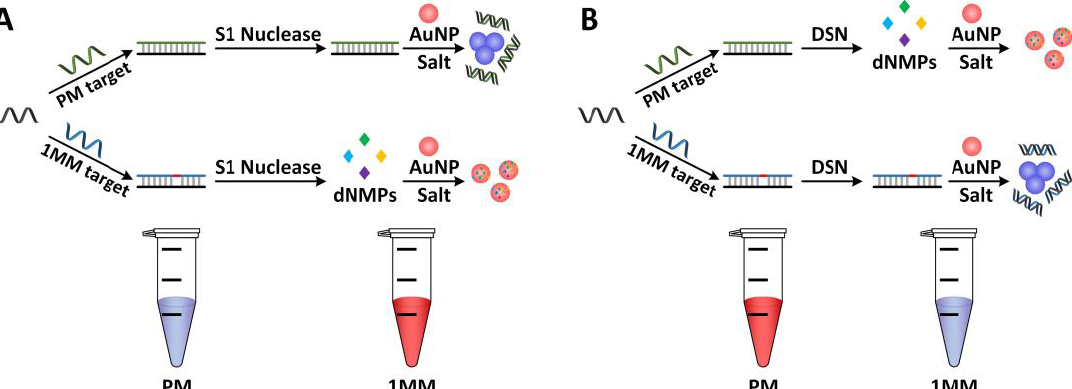
Figure 8. Schemes for detecting single-base mismatches without using optical labels. ( A ) The scheme was illustrated in the case of the S1 nuclease, and various DNA structures were used. S1 nuclease hydrolyzes mismatched DNA duplexes to 5′ -phosphoryl-terminated products, but not perfectly matched duplexes. ( B ) Diagram of the DSN-based, label-free optical detection of SNPs. Lower left: images of the AuNP solution containing the probe, S1 nuclease, and various targets (PM or 1MM). Images of AuNP solution containing a probe, various targets, and duplex-specific nuclease are shown on the right bottom (DSN). The assays were incubated at 65 °C for 7.5 min before adding AuNP and the salt solution. Photographs were taken 2 min after a 40 µL salt solution was added. Reproduced with permission from Ref. [112]. Copyright 2011, Elsevier.